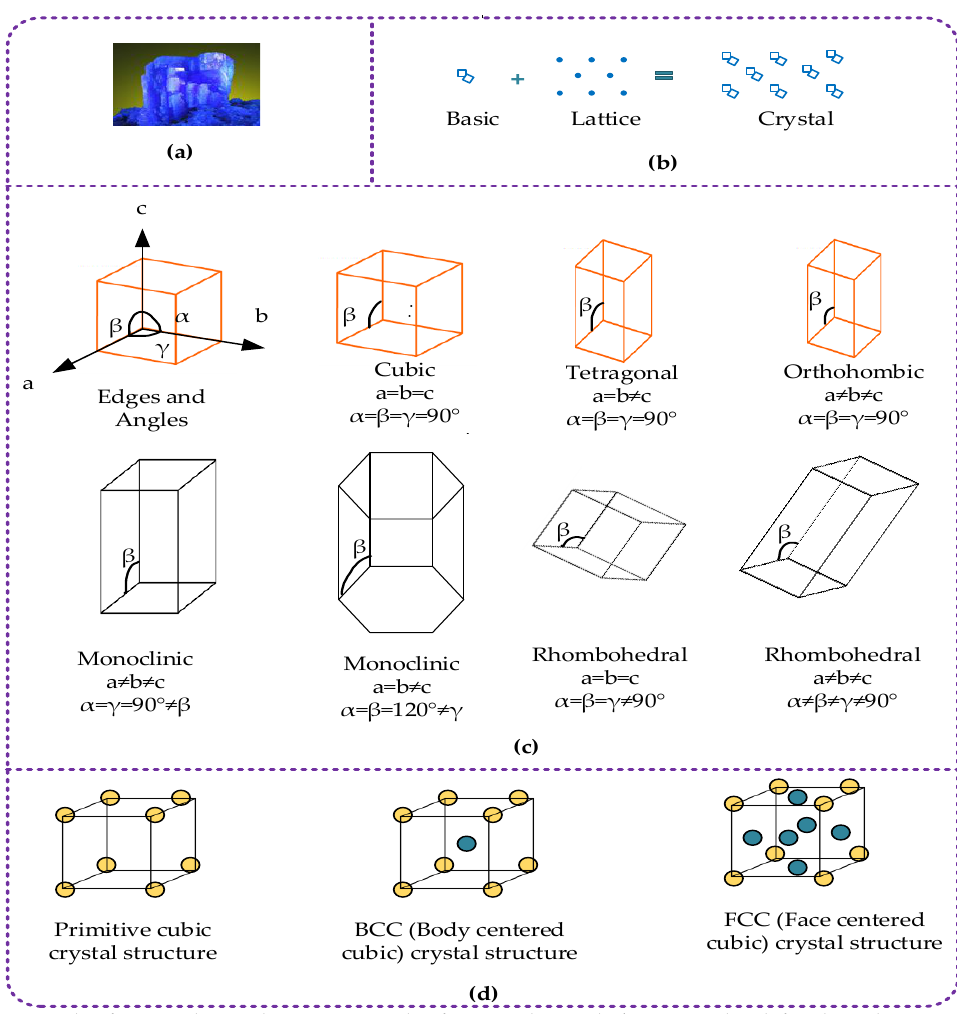
Figure 5. Example of a typical crystal: ( a ) An example of a natural crystal. ( b ) A crystal is defined as a lattice with a basis adjoined it; ( c ) Several lattice configurations choices; ( d ) Three frequent variety of cubic crystal systems ( a , b , d ).